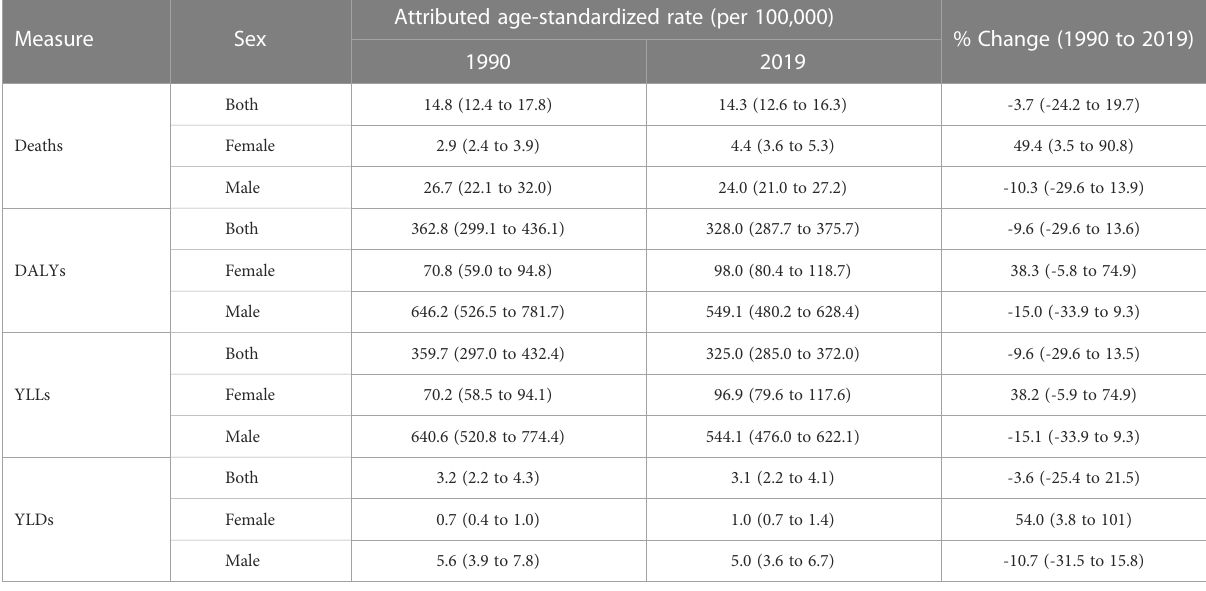
TABLE 3 Attributed age-standardized rate (per 100,000) of deaths, DALYs, YLLs, and YLDs to all risk factors in region by sex in 1990 and 2019 with their percent changes. Attributed age-standardized rate (per Measure